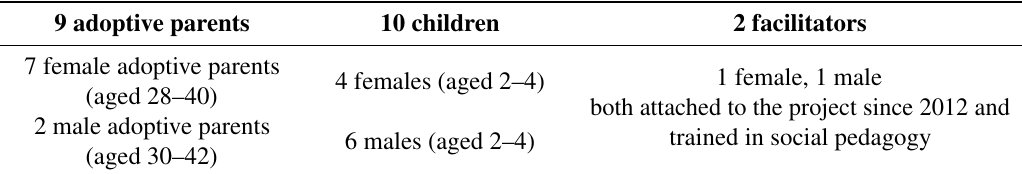
Table 1. Sample of